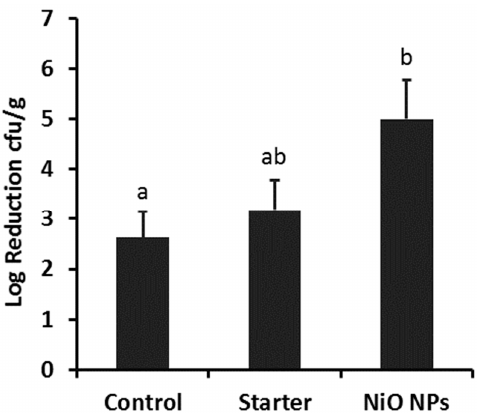
Figure 6. Comparison between the inactivation levels of yoghurt starter culture and nickel oxide